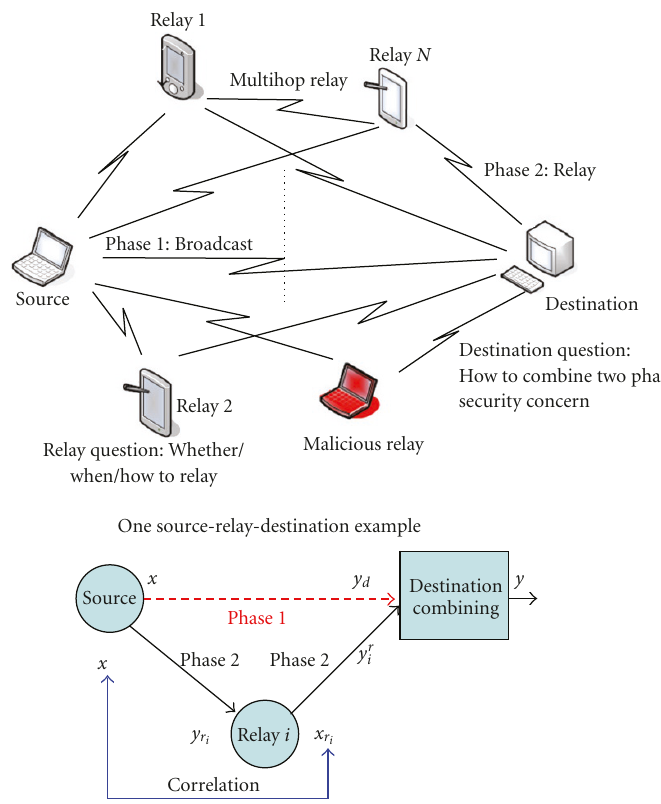
Figure 1: Cooperative transmission system